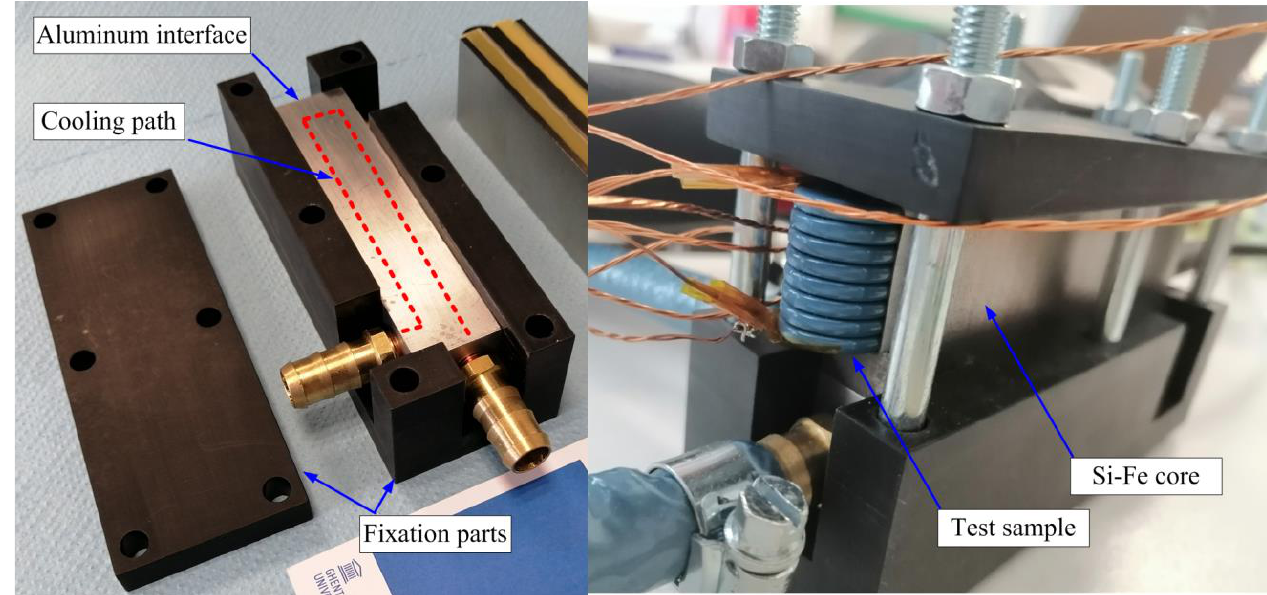
Figure A1. Assembly of a test sample with a cooling jacket for temperature control.